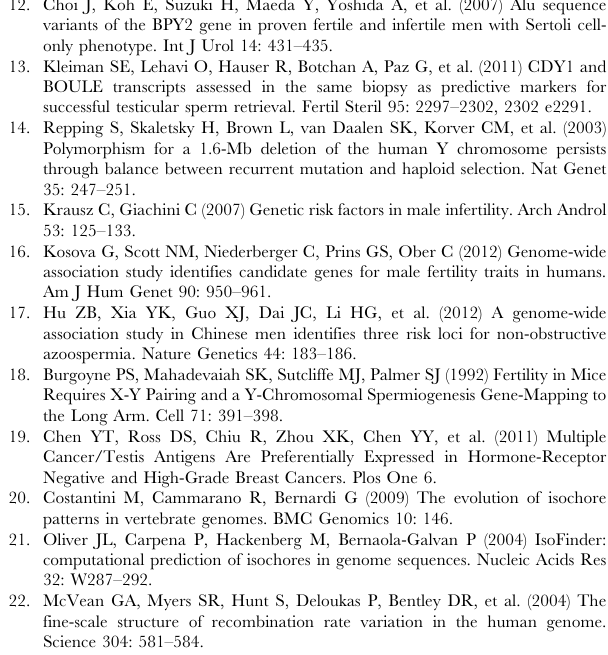
Table S1 Isochore characterization of 50 CSFRs.